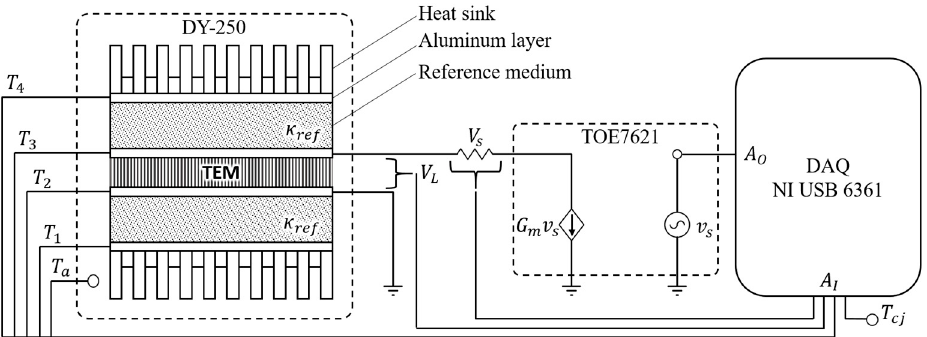
Figure 3. Automatic measurement setup.